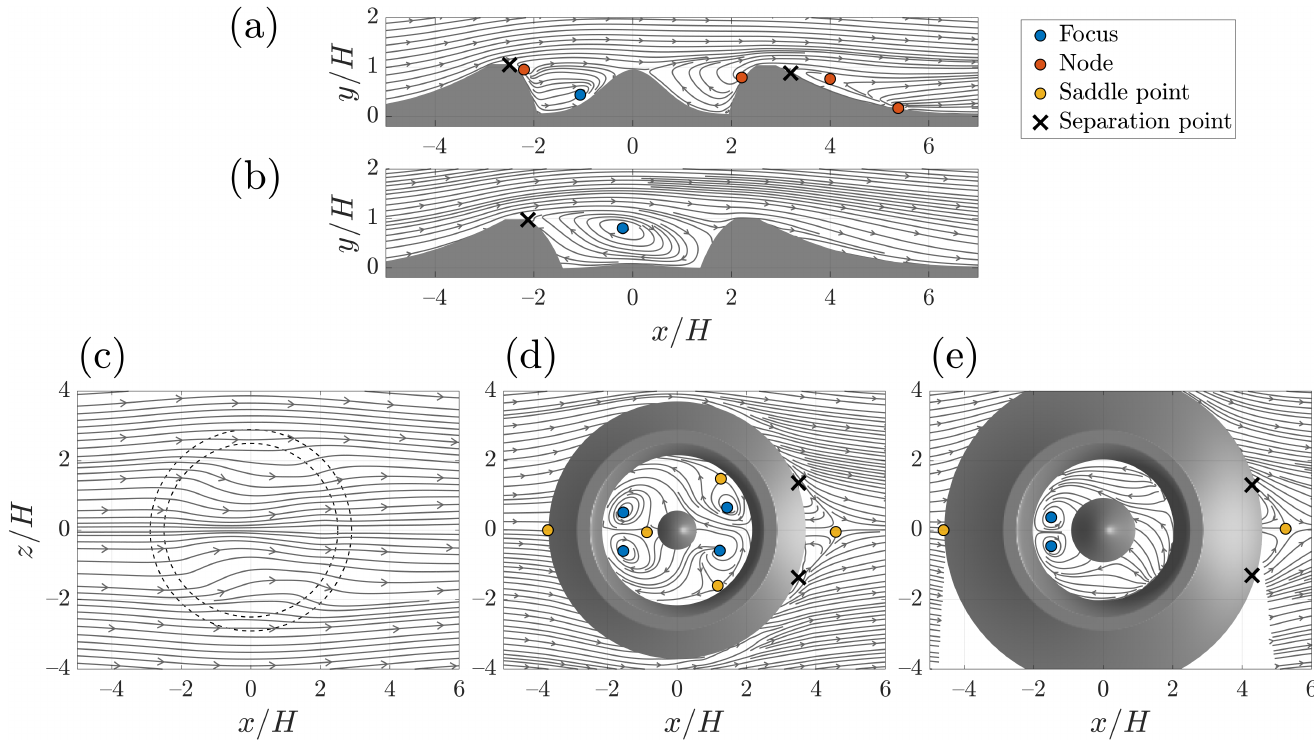
Figure 8. Mean streamlines and distribution of critical points (i.e., (cid:104) U (cid:105) = (cid:104) V (cid:105) = 0) in different measurement planes calculated using the Chong et al. [29] formulation. ( a , b ) Streamwise wall-normal planes; ( c , d ) streamwise wall-parallel planes; ( a ) centerline plane, z / H = 0; ( b ) offset plane, z / H = 1.3; ( c ) top-plane, y / H = 1.1 (the location of the crater rim is indicated by the dashed lines for reference); ( d ) mid-plane, y / H = 0.6; and ( e ) bottom-plane plane, y / H = 0.3. Re H = 8.9 × 10 3